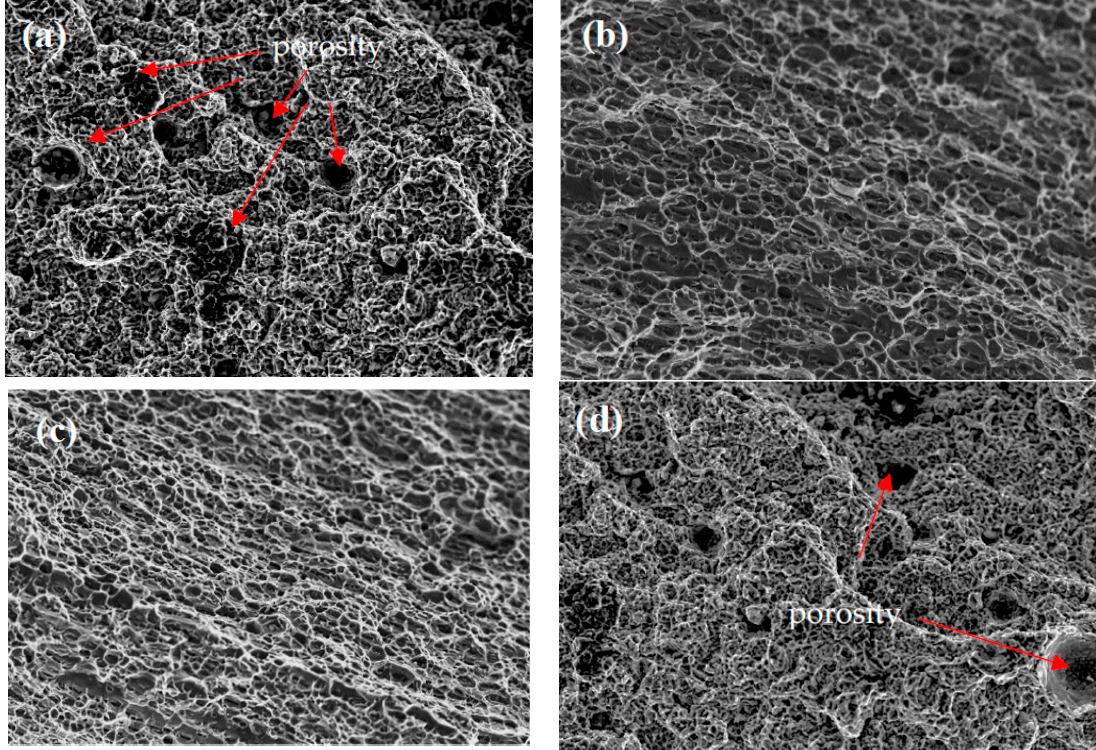
Figure 13. Fracture microscopic morphology of weld joints for ( a ) the normal-pulse welding and ( b ) f d = 1 Hz, ( c ) f d = 3 Hz, and ( d ) f d = 5 Hz double-pulse welding processes.